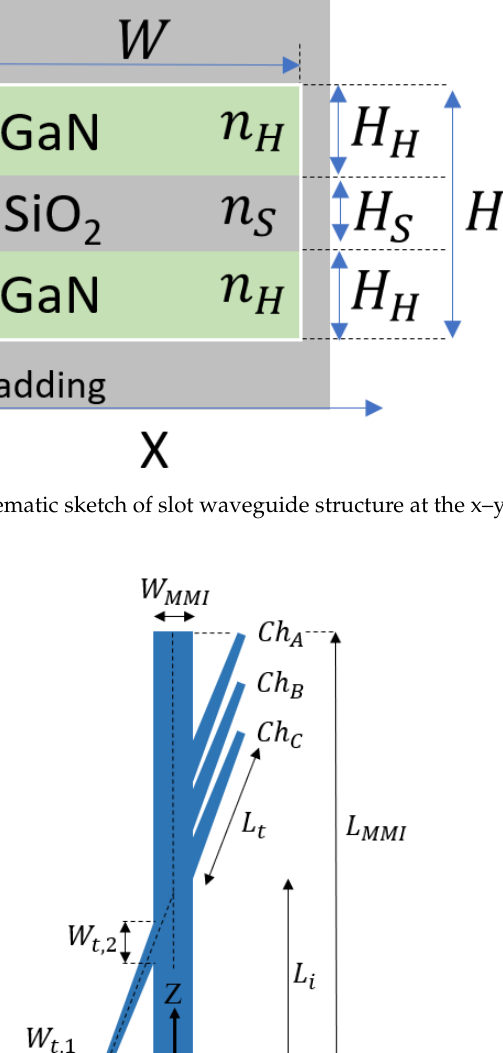
Figure 1. Schematic sketch of slot waveguide structure at the x–y plane.